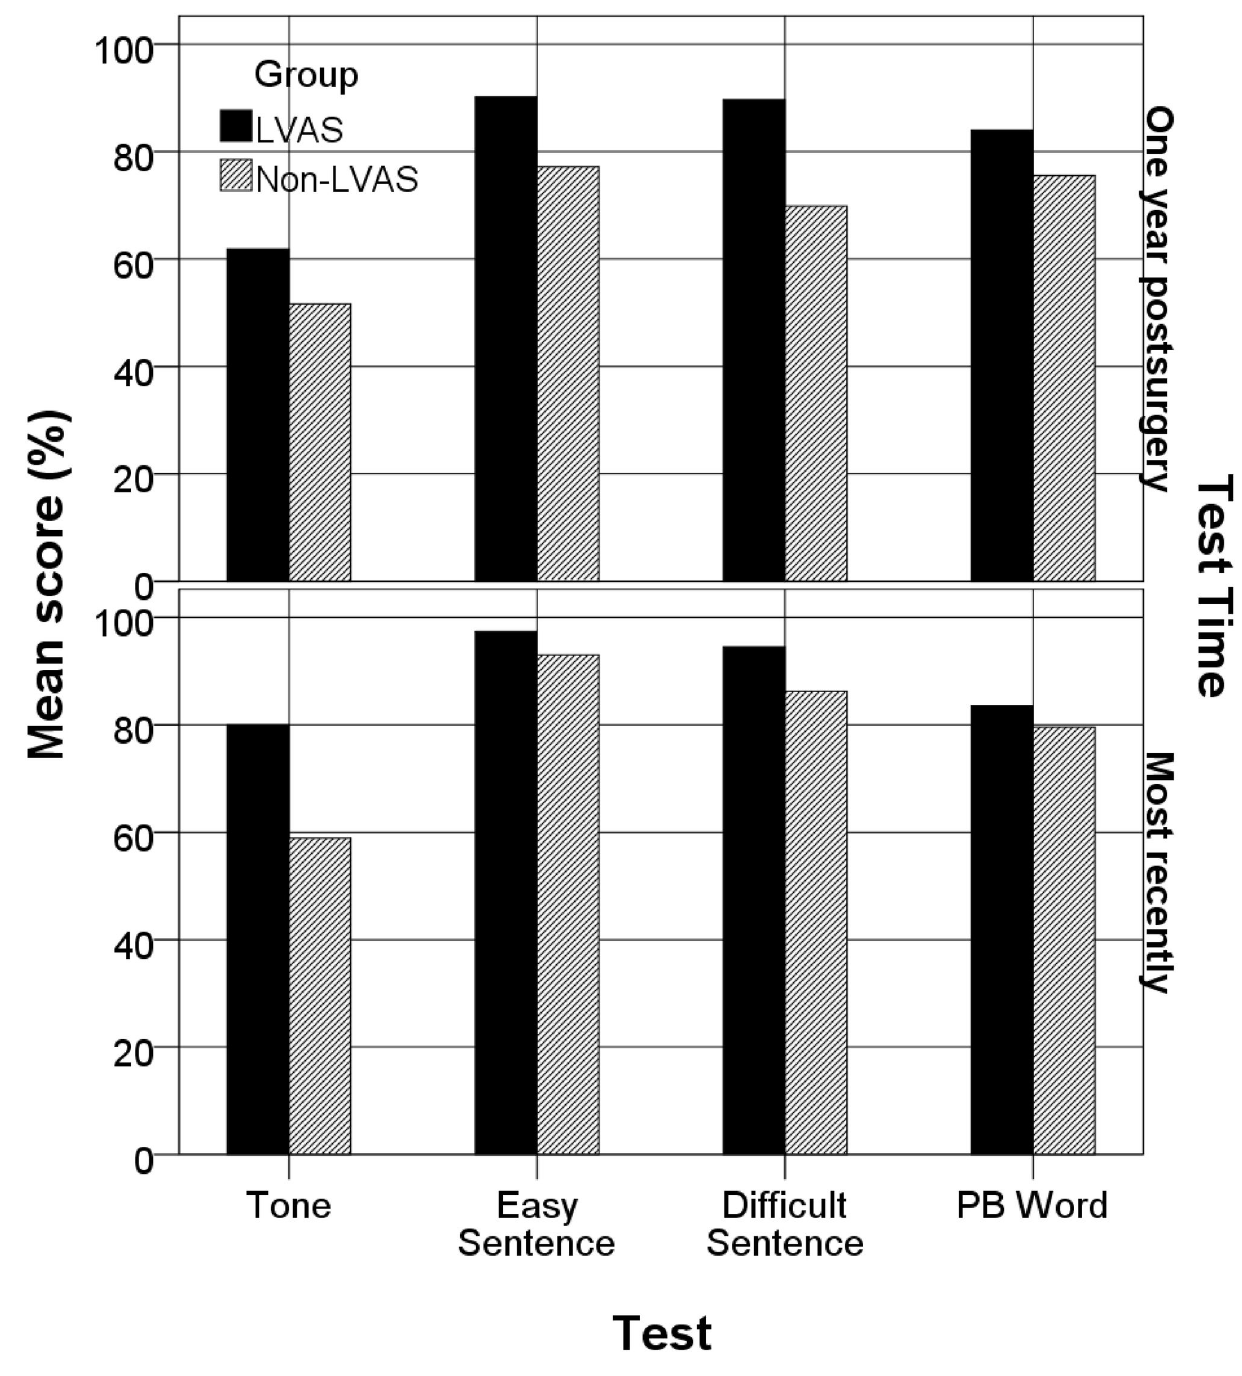
Figure 1. Mean scores on speech perception tests for the LVAS group and Non-LVAS group. The mean scores for four speech perception tests obtained one year after implantation and at the most recent follow-up visit by the LVAS group and the non- LVAS